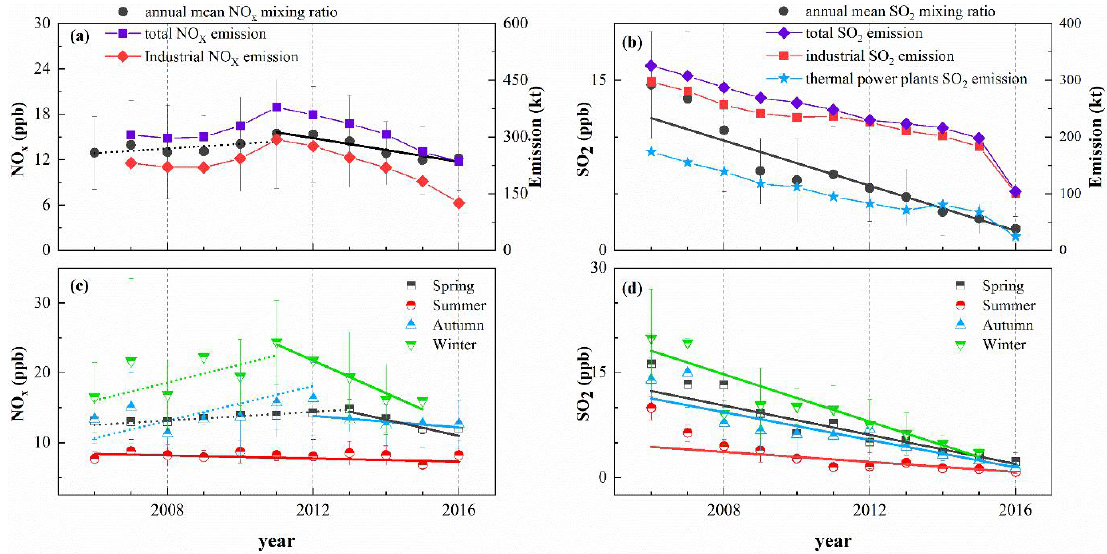
Figure 8. Annual mean NO x mixing ratio at LAN (left axis) compared with total NO x emission and industrial NO x emission in the YRD ( a , right axis); annual mean SO 2 mixing ratio at LAN (left axis) compared with total SO 2 emission, industrial SO 2 emission and thermal power plant SO 2 emission in the YRD ( b , right axis); seasonal average annual variation in NO x (c) ; SO 2 (d) at LAN. Table 4. Annual percentage changes in NO x and SO 2 in various regions. Location Period Base year NO x SO 2 LAN, this